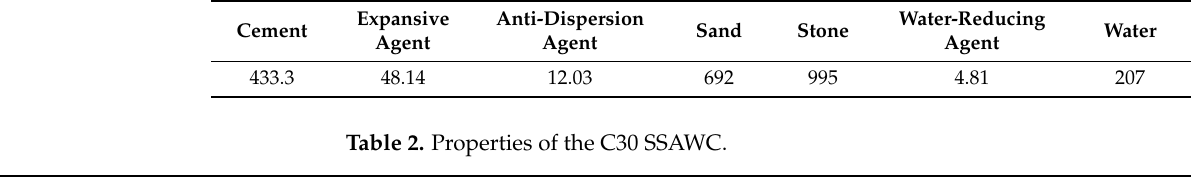
Table 1. The mix ratio of the C30 SSAWC (kg/m 3 ).